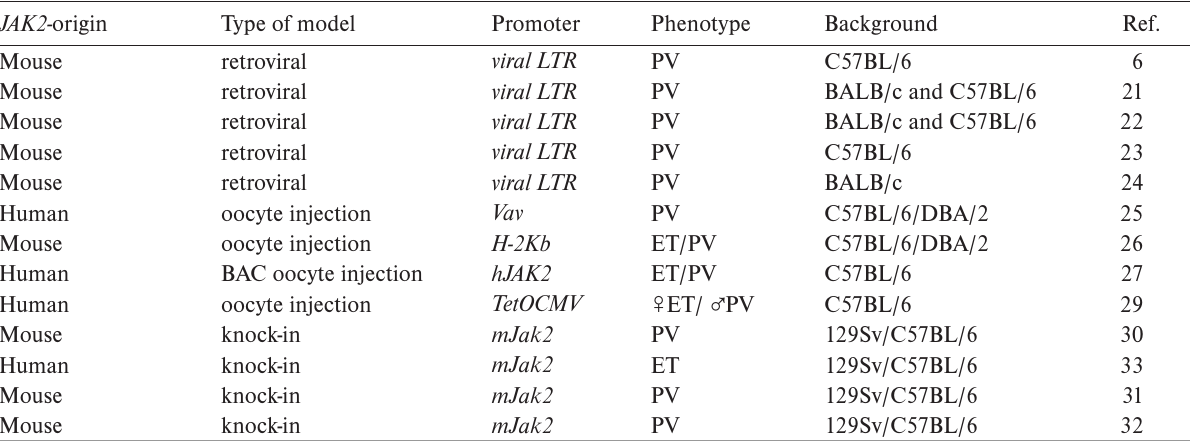
Table 1. MPN mouse models with JAK2